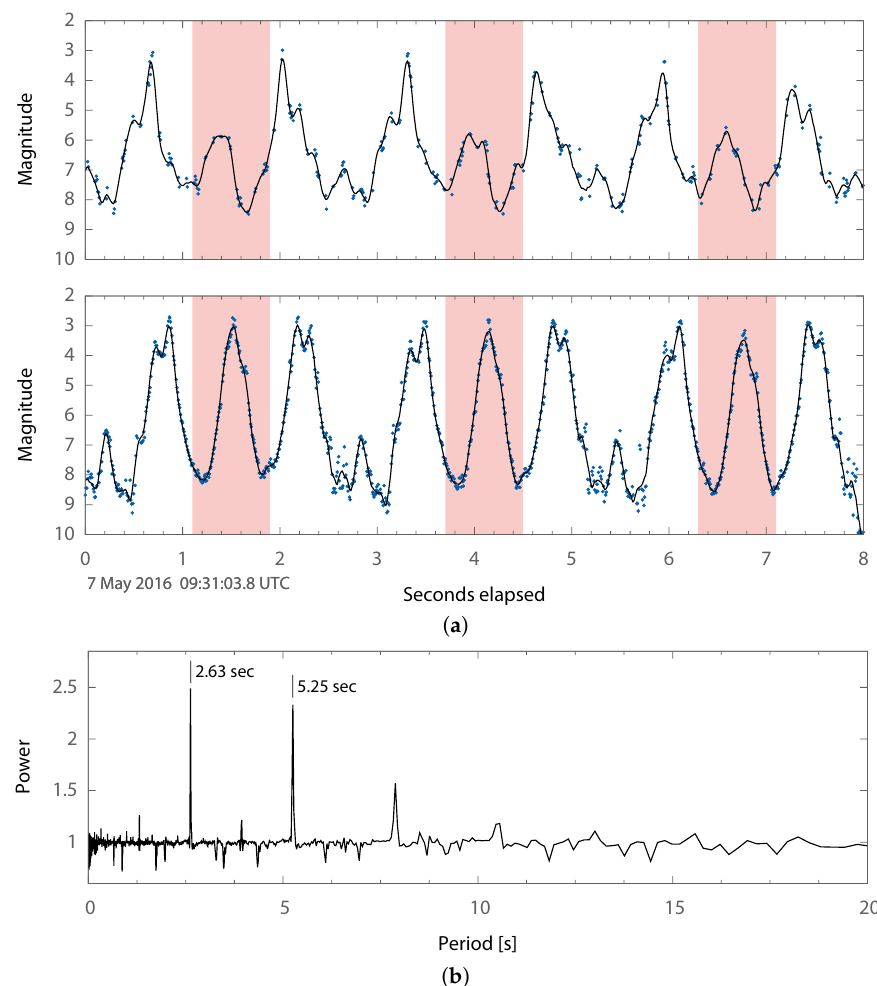
Figure 10. ( a ) the ASTRO-H parent body (Spacetrack ID 41337) observed after fragmentation event using identical OSCOM systems from Daytona Beach, FL, USA (top) and West Palm Beach, FL , USA (bottom). These observations used an integration time of 5ms for an imaging cadence of 135Hz. Some frames were dropped at the Daytona Beach site, causing occasional data gaps. The smoothing lines are 10 point centered moving averages. The line for the Daytona Beach site is drawn for a 10ms resampled version of the data that was interpolated with the piecewise cubic Hermite interpolating polynomial (PCHIP) algorithm, but only the original data are shown as points. ( b ) Plavchan periodogram produced from a 1 min segment of the 7 May 2016 observation in West Palm Beach, FL,